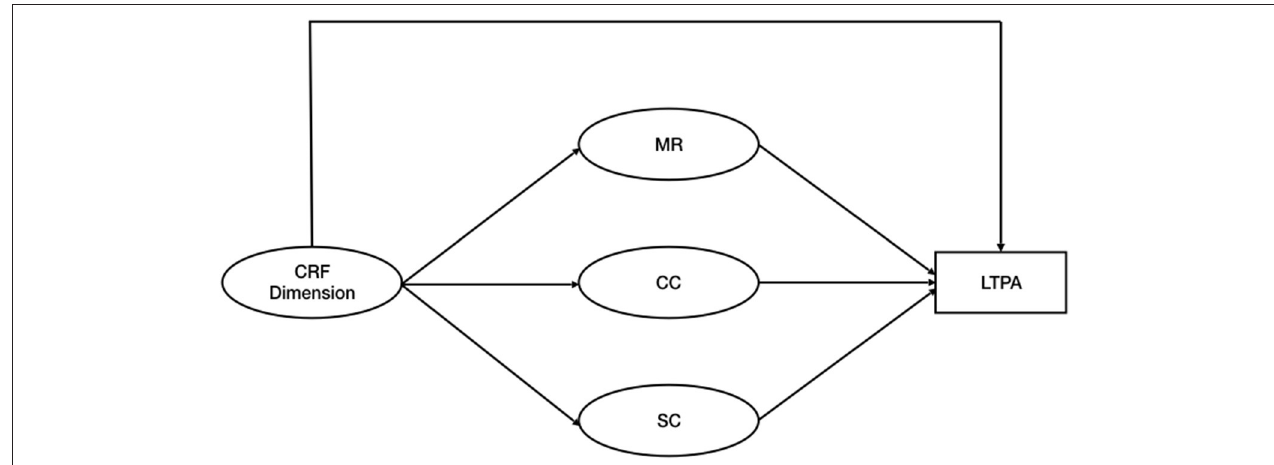
FIGURE 1 | Hypothesized mediation model. CRF, Cancer Related Fatigue; MR, Physical Activity Specific Mood Regulation; CC, Control Competence for Physical Training; SC, Physical Activity Specific Self Control; LTPA, Leisure Time Physical